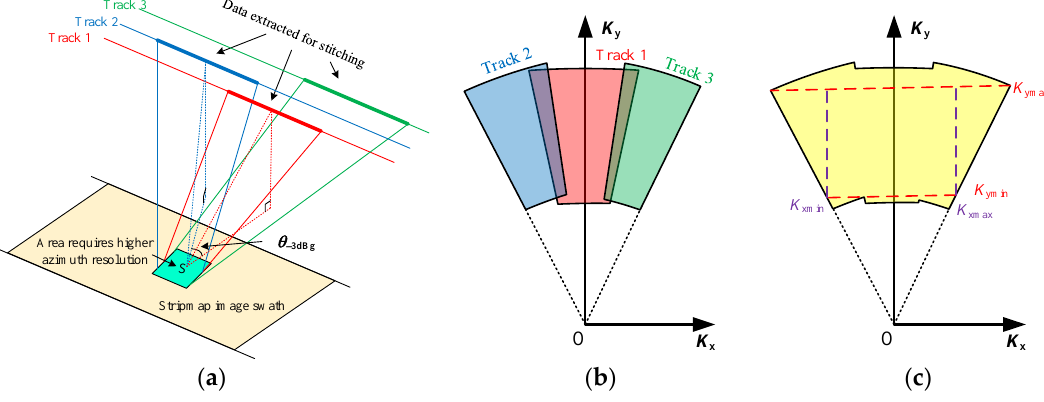
Figure 5. Illustrations of ( a ) the data selection, the wavenumber spectrums of ( b ); the selected data segments, and ( c ) the stitched data.